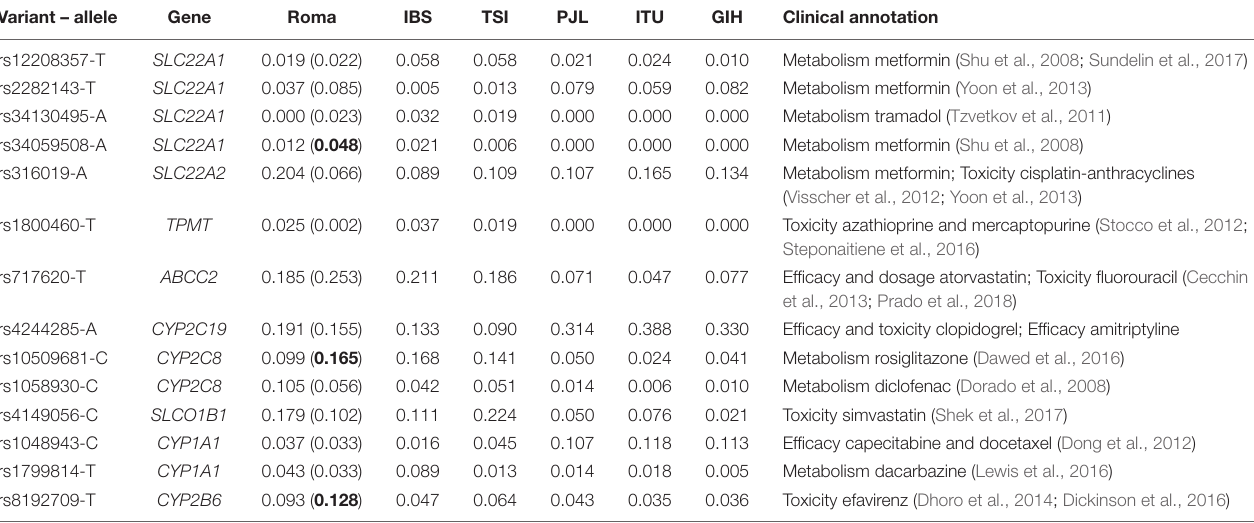
TABLE 3 | List of variants in ADME genes found to have a fold increase in allele frequency equal or higher than 1.5 comparing Roma and non-Roma. Variant –